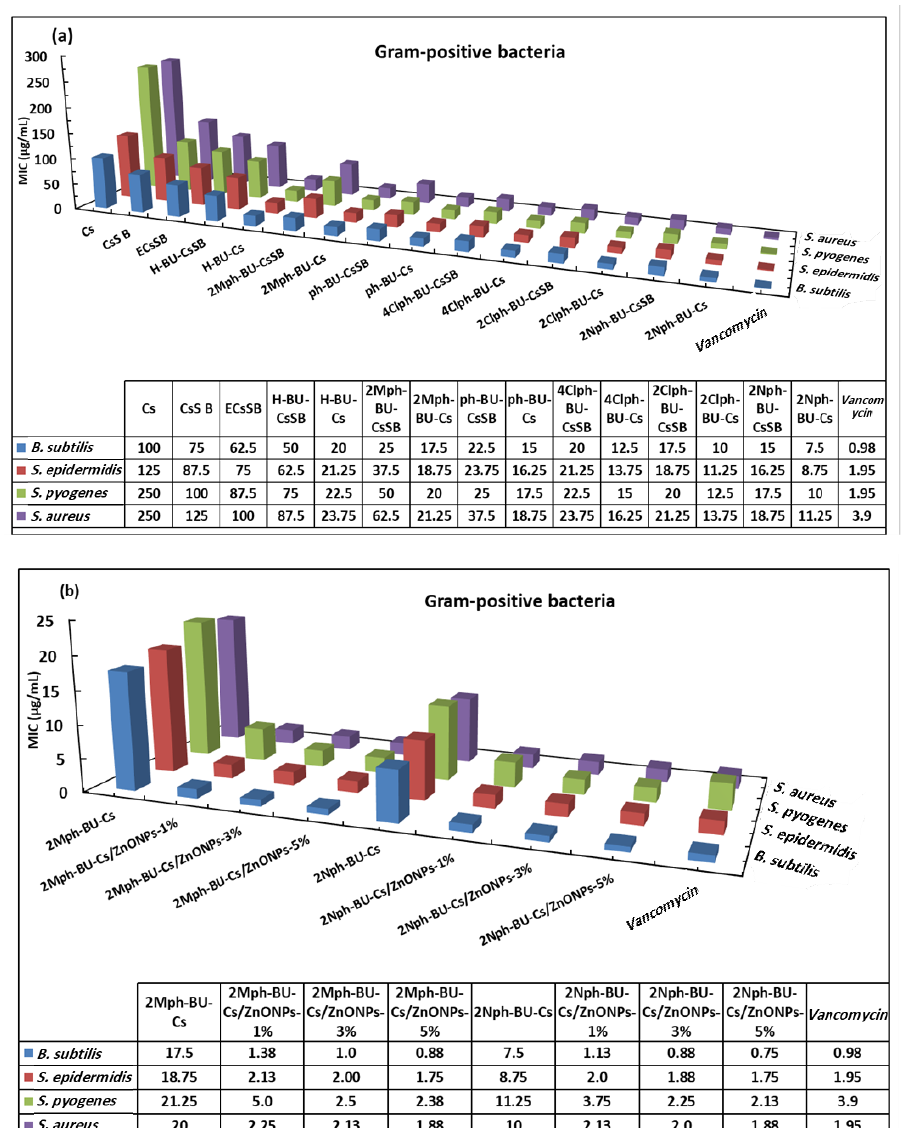
Figure 10. MIC index for: ( a ) R-BU-CsSB and R-BU-Cs hydrogels and ( b ) 2Nph-BU-Cs/ZnONPs and 2Mph-BU-Cs/ZnONPs composites against the inspected Gram-positive bacteria.